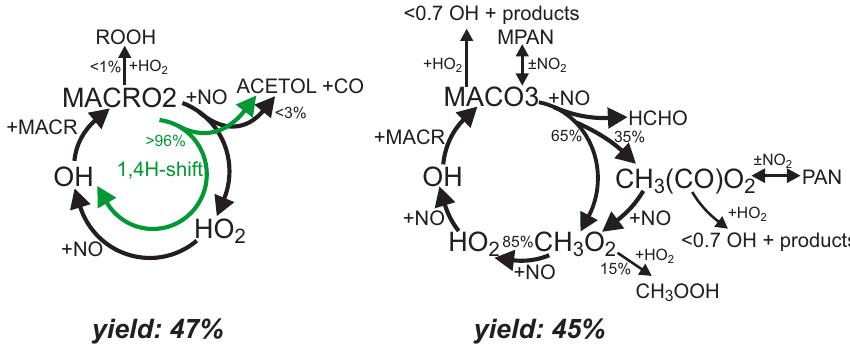
Figure 6. Schematics of radical recycling from the reaction of MACR with OH taken from MCM (black arrows) showing the reactions which were of importance for conditions of these experiments. H-atom abstraction of the CHO group in MACR leads to the formation of an acyl peroxy radical (MACO3: yield 45%), whereas OH addition to the C = C double bond forms two hydroxyalkoxy radical isomers (RO 2 : MACRO2, yield 47%, and MACROHO2, yield 8% (not shown here)). Green arrows indicate the 1,4-H-shift reaction of MACRO2 (Crounse et al., 2012) (the less important 1,5-H shift is not shown here). Branching ratios are given for conditions of the experiment on 11 August 2011 (NO = 90pptv, HO 2 = 5 × 10 8 cm − 3 , T = 301K) if the fast unimolecular reaction is